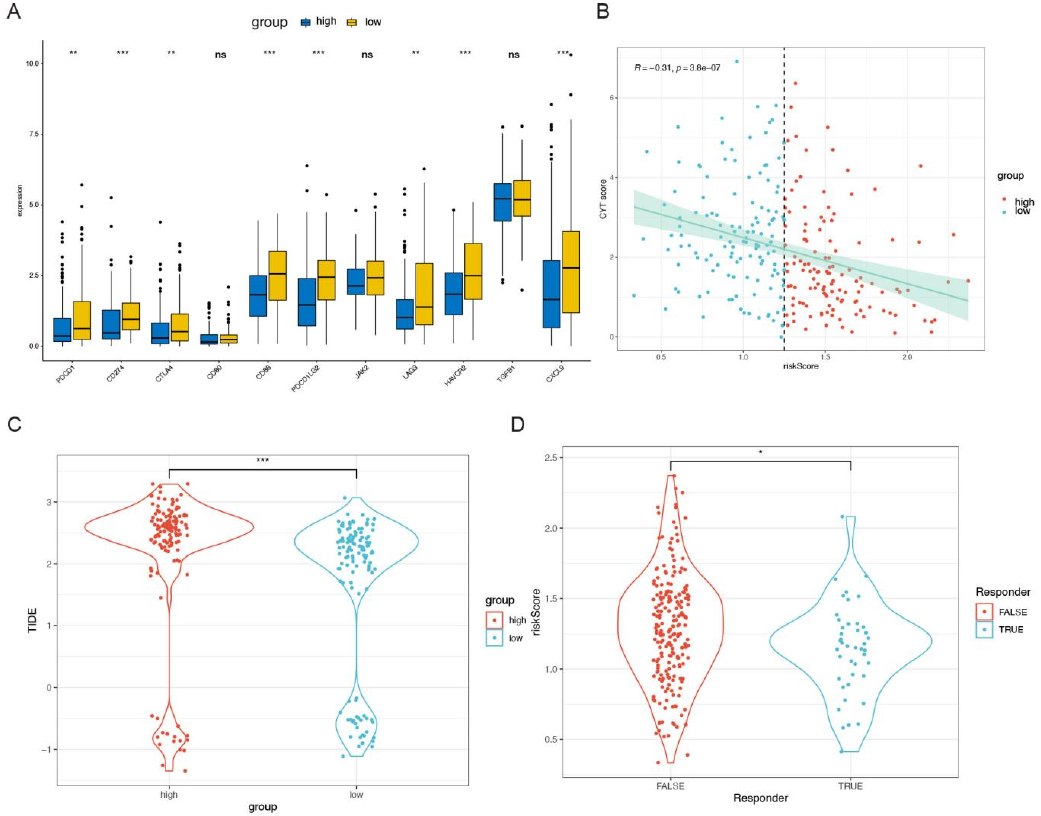
Figure 9. The association of CRGs with immune checkpoints predicting the response to chemother- apy. ( A ) The differences in expression levels of immune checkpoints between the in patients with sarcoma. ( B – D ) The results of CYT, TIDE1, and TIDE2. CYT: cytolytic activity, TIDE: tumor immune dysfunction and exclusion . * p < 0.05. ** p < 0.01. *** p < 0.001. ns: not significant.